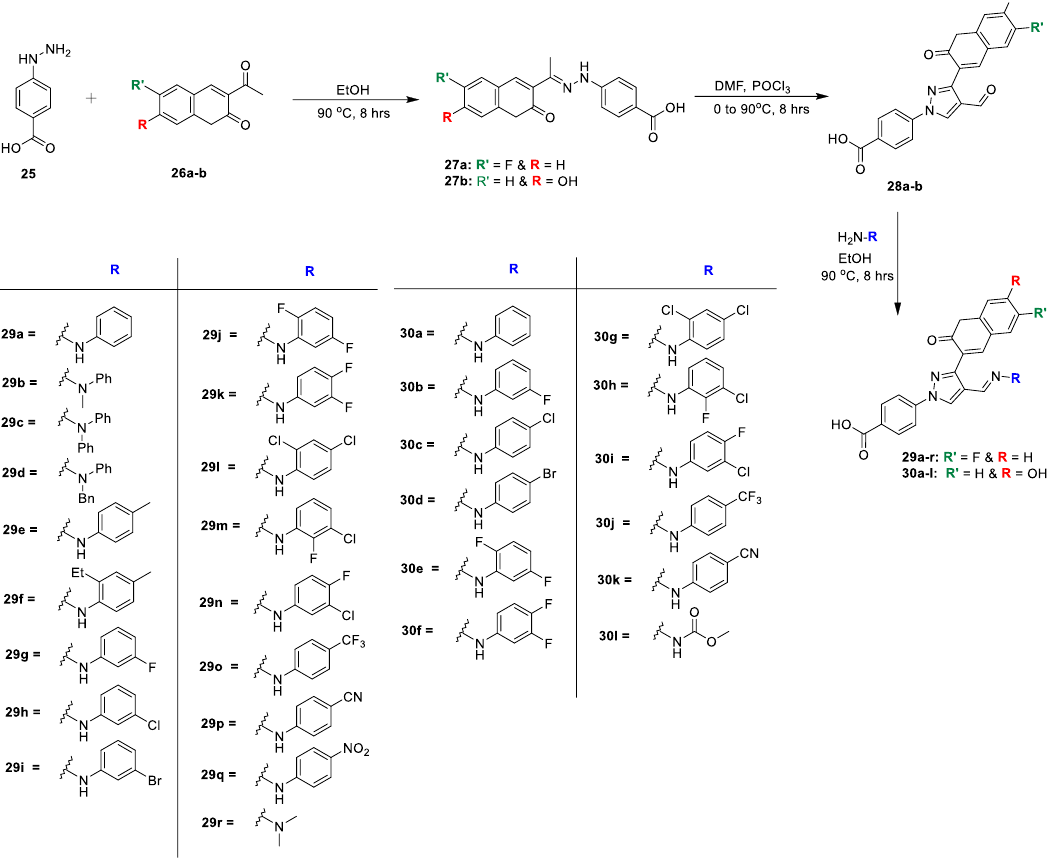
activity with Izs 15 – 19 mm, whereas analogues 38c , d 39c,d, and 41c,d displayed the max- imum Izs and revealed potent antimicrobial action towards the tested microorganisms when compared to the reference with a MIC of 125 µg/mL. However, 38d established re- markable broad-spectrum potential towards all the tested microorganisms with a MIC of 125 µg/mL. Analogues bearing sulfadiazine or 4-hydroxyphenyl moieties, 38c – d and 39c – d, revealed fairly excessive antibacterial potential (30 mm) compared to the standard ciprofloxacin (28 mm) against S. aureus with a MIC of 125 µg/mL, while analogues con- taining sulphanilamide or 4-chlorophenyl substitutions ( 38a and 41c,d ) exhibited equal Figure 3. Two-dimensional representation of the interactions of 24e in the active site 3LD6 complex. antibacterial potential against S. aureus than the standard analogue ciprofloxacin (28